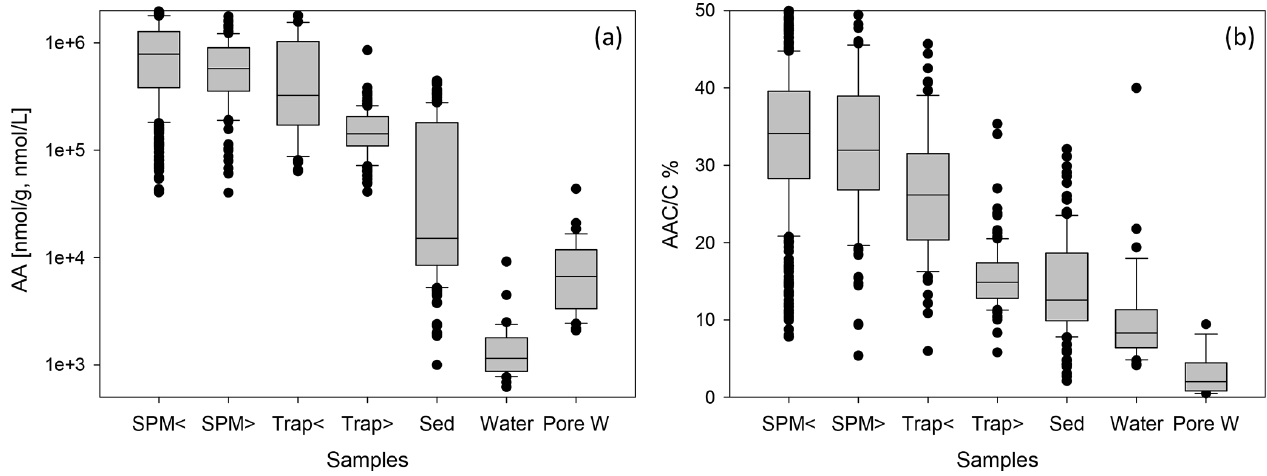
Figure 2. Box-and-whisker plots of AA concentrations in nmolg − 1 or nmolL − 1 (a) and of AAC / C (b) in SPM from water depths < 200 (SPM < ) and > 200m (SPM > ), in sediment traps at water depth < 200 (Trap < ) and > 200m (Trap > ), in sediments (Sed), in water samples (Water), and in pore water samples (Pore W). Boxes comprise the upper and lower quartiles, and lines indicate the median. Whiskers delineate the 10th and 90th percentiles. Outliers are marked by dots. Some outliers above the 90th percentile are cut off in the figure for better perceptibility of trends.